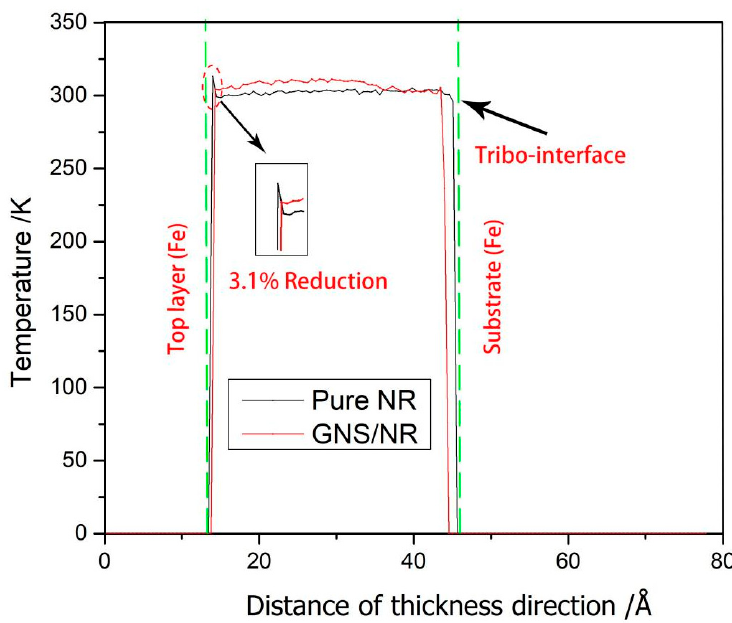
Figure 7. Temperature distribution of the pure NR and GNS/NR composites in the thickness direction.